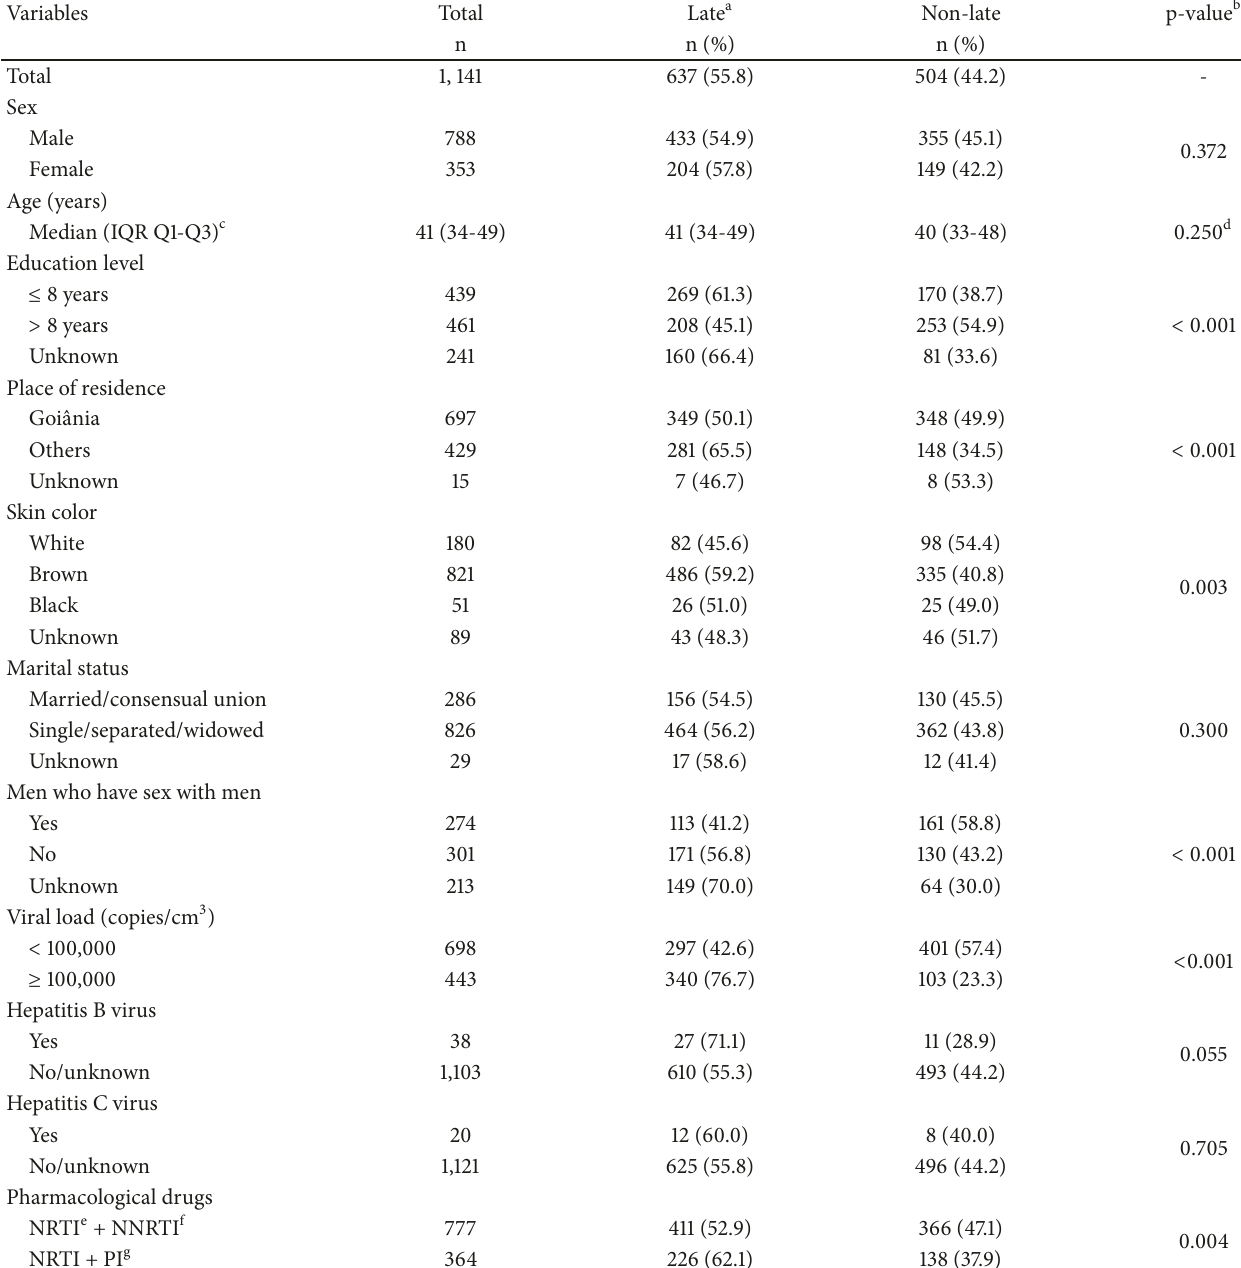
Table 1: Baseline characteristics of 1,141 participants, comparing late versus nonlate antiretroviral therapy initiation,